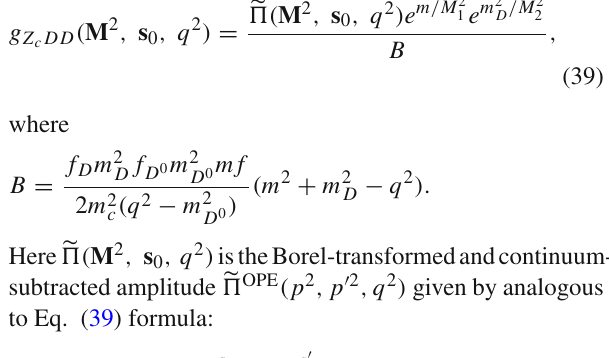
Fig. 3 The strong coupling g Z parameters M 2 = ( M 2 and Q 2 = 5 GeV